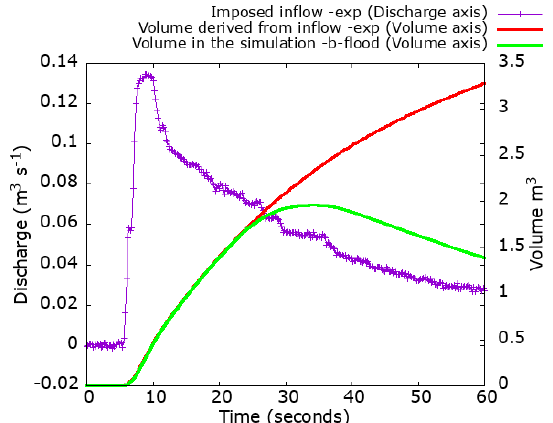
Figure 13. Hydrograph of the imposed inflow on the left bound- ary. Comparison of the volume of water in the simulation and the experimental one.